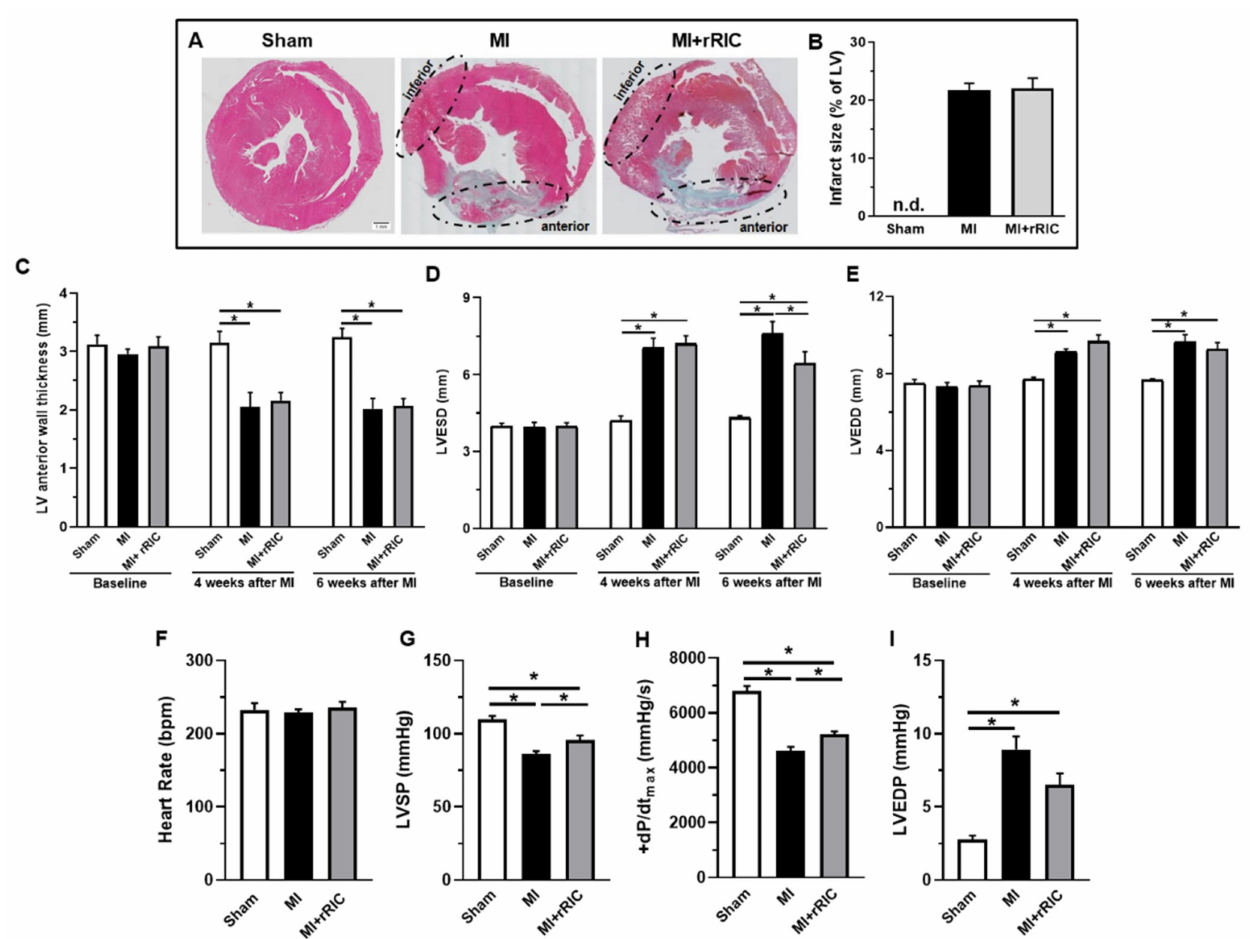
Figure 2. Histological analysis and functional characteristics of the infarcted hearts. Representative Masson’s trichrome- stained cross-sections are shown from the Sham, MI, and MI + rRIC groups ( A ). Red staining identifies viable myocardial tissues without scar formation in the inferior region (non-infarcted area) of the left ventricle (LV), while blue staining shows scar formation in the anterior region (infarcted area) of LV following MI. Quantitative aspects of myocardial infarct sizes are given in a bar graph ( B ). Time courses of systolic LV anterior wall thickness and LV dimensions at baseline, 4 or 6 weeks after MI induction as determined by echocardiography. Panels ( C – E) illustrate systolic LV anterior wall thickness, LV end-systolic diameter (LVESD), and LV end-diastolic diameter (LVEDD) in the Sham, MI and MI + rRIC groups. Heart rate, LV peak systolic pressure (LVSP), maximal rate of rise of LV pressure ( + dP/dt max ), and LV end-diastolic pressure (LVEDP) at six weeks after MI induction are also given for the three experimental groups panels ( F – I ). Values are given as mean ± SEM; n = 4–6 animals/group. * p <